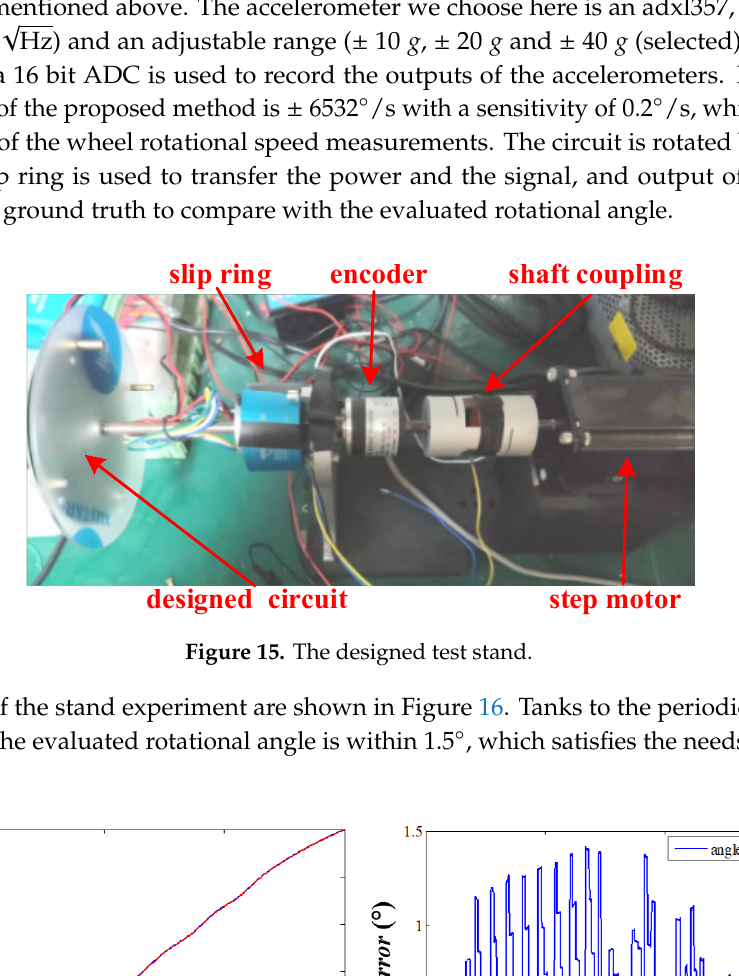
Figure 16. The results of the stand experiments.